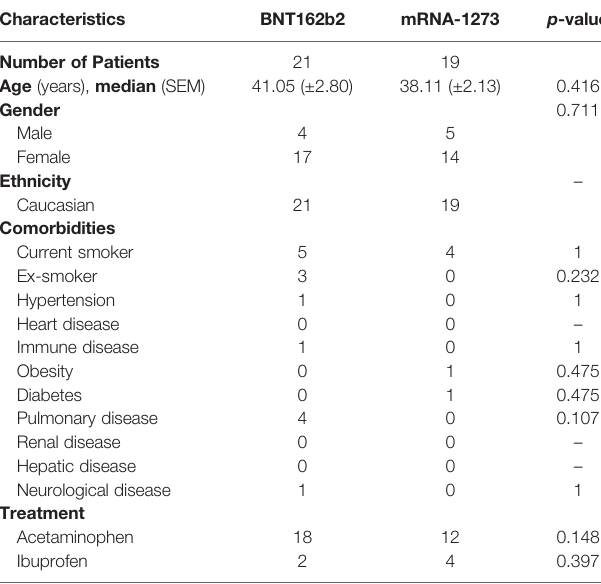
TABLE 1 | Demographic and clinical characteristics of the BNT162b2 and mRNA-1273